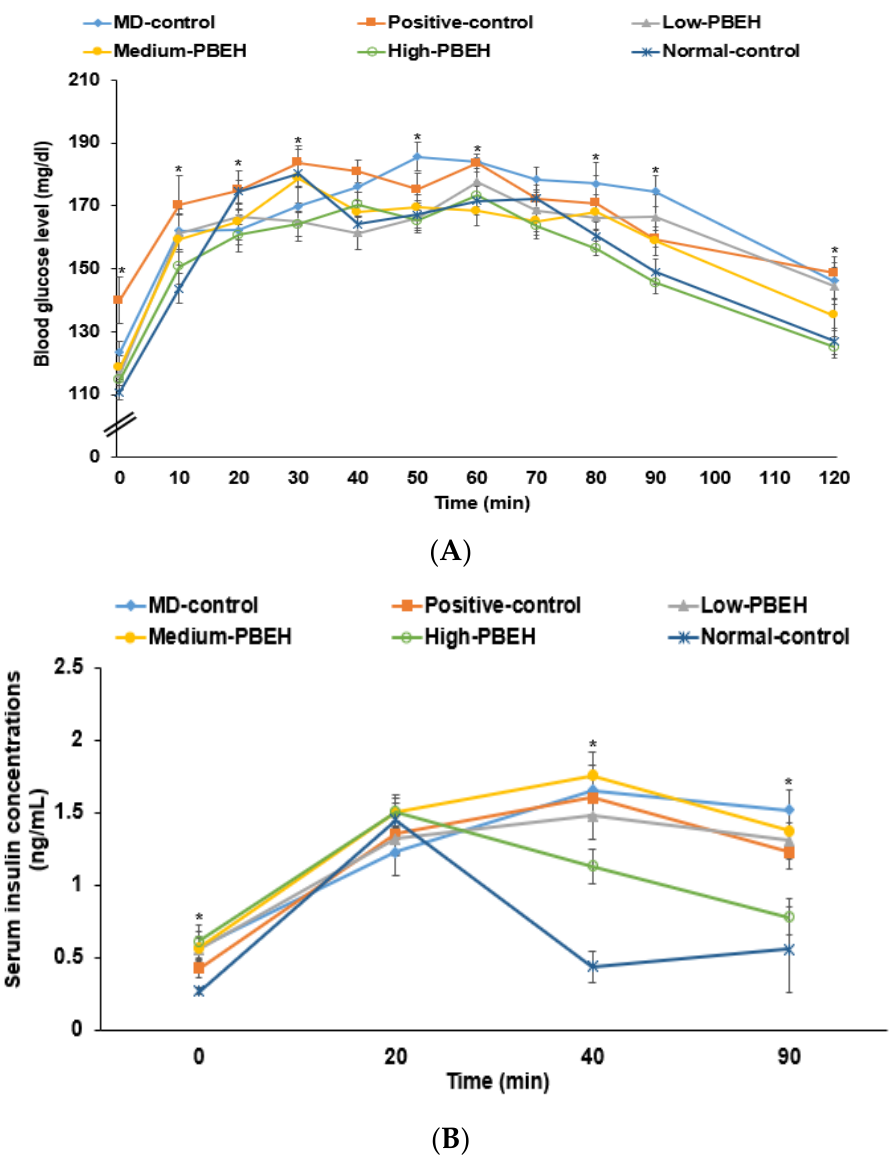
Figure 3. Changes in serum glucose and insulin concentrations and areas under the curve during oral glucose tolerance testing (OGTT) and intraperitoneal insulin tolerance testing (IPITT). Male rats had intraperitoneal injections of scopolamine (2 mg/kg body weight/day) at 30 min after daily feeding of casein (MD-control), porcine brain enzyme hydrolysates (PBEH; 7 mg total nitrogen/mL) at 0.053 mL (Low-PBEH), 0.159 mL (Medium-PBEH), 0.478 mL (High-PBEH), or 10 mg donepezil (Positive-control) per kilogram body weight per day for six weeks. ( A ) Changes in serum glucose concentration during oral glucose tolerance test after oral consumption of 2 g glucose/kg body weight; ( B ) changes of serum insulin concentrations during OGTT; dots and error bars represent the means ± standard deviations ( n = 10). * Significantly different among the groups at each time point at p < 0.05.